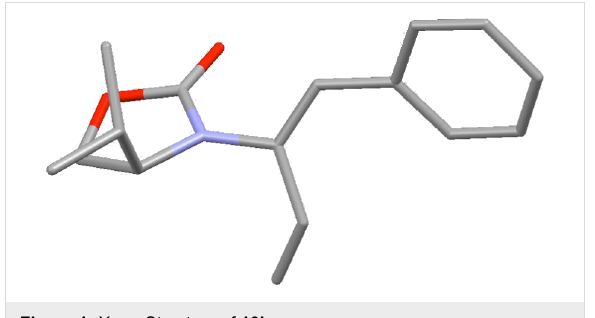
Figure 1: X-ray Structure of 10b